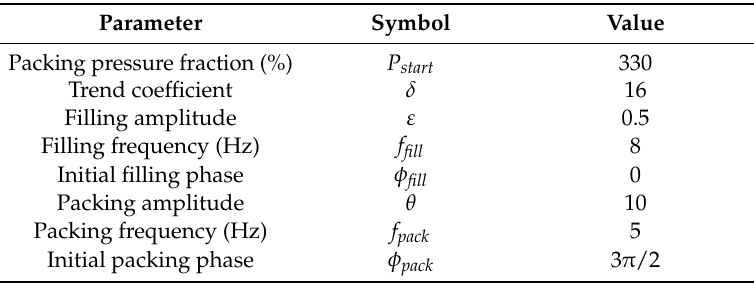
Table 3. Dynamic injection molding parameters used in this